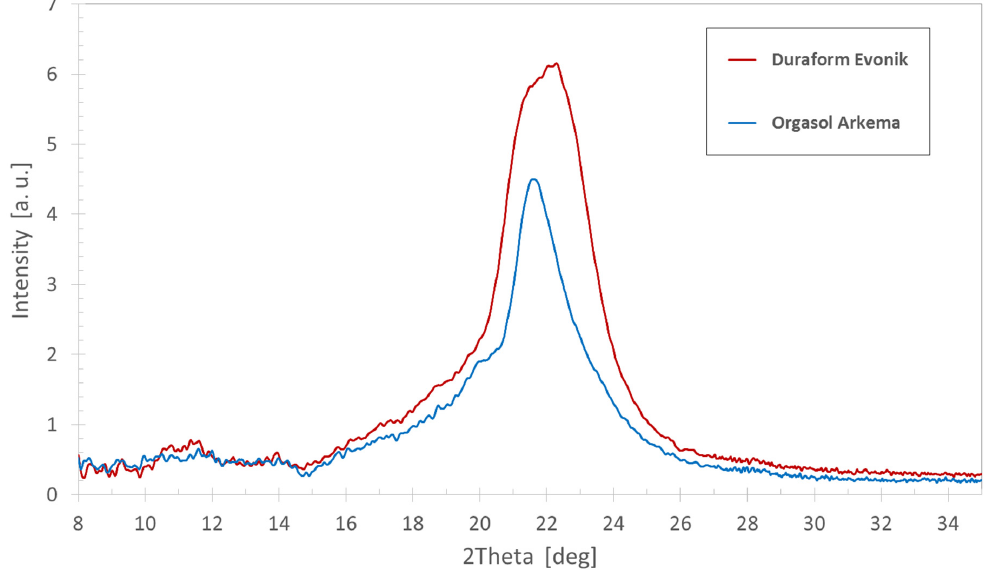
Figure 7. X ‐ ray diffraction (XRD) patterns of Orgasol ‐ IS and DF ‐ PA. Figure 7. X-ray diffraction (XRD) patterns of Orgasol-IS and